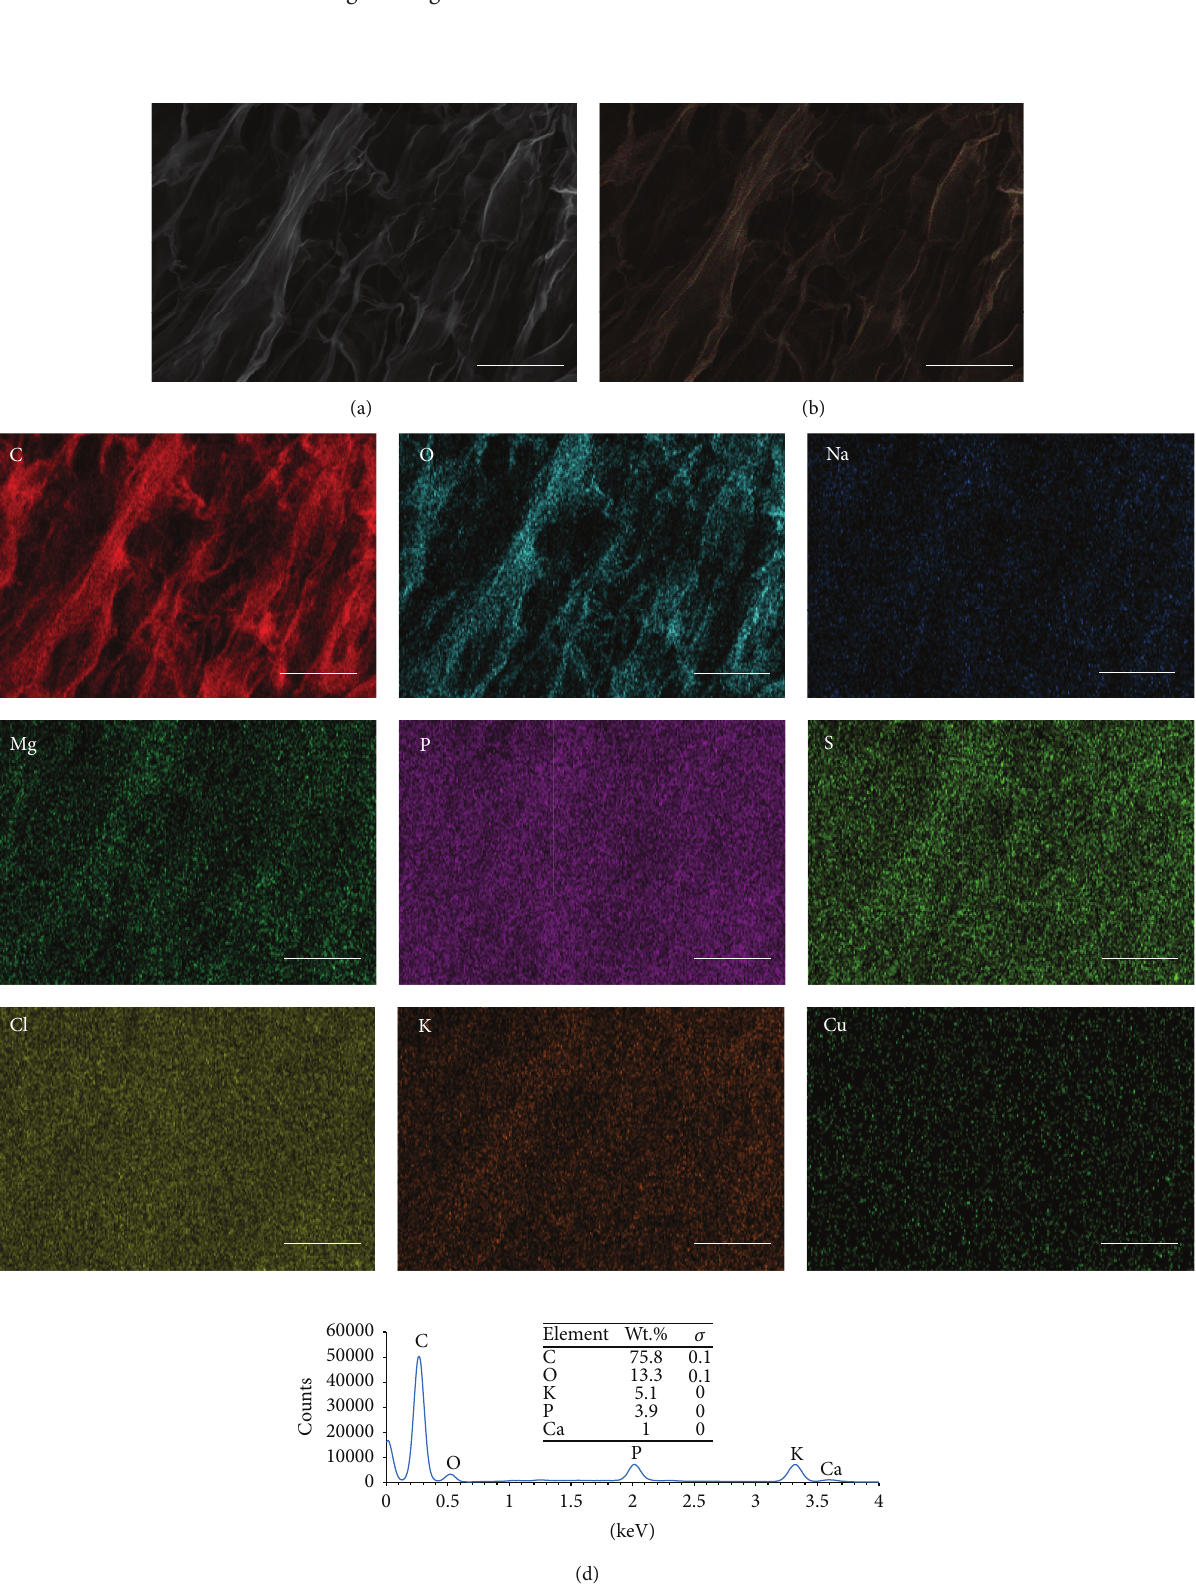
Figure 4: Elemental mapping of CT after DI H 2 O wash, including the raw electron image (a), composite image (b), and maps of most prominent elements in the specimen (all scale bars = 25 𝜇 m), with accompanying EDS spectrum